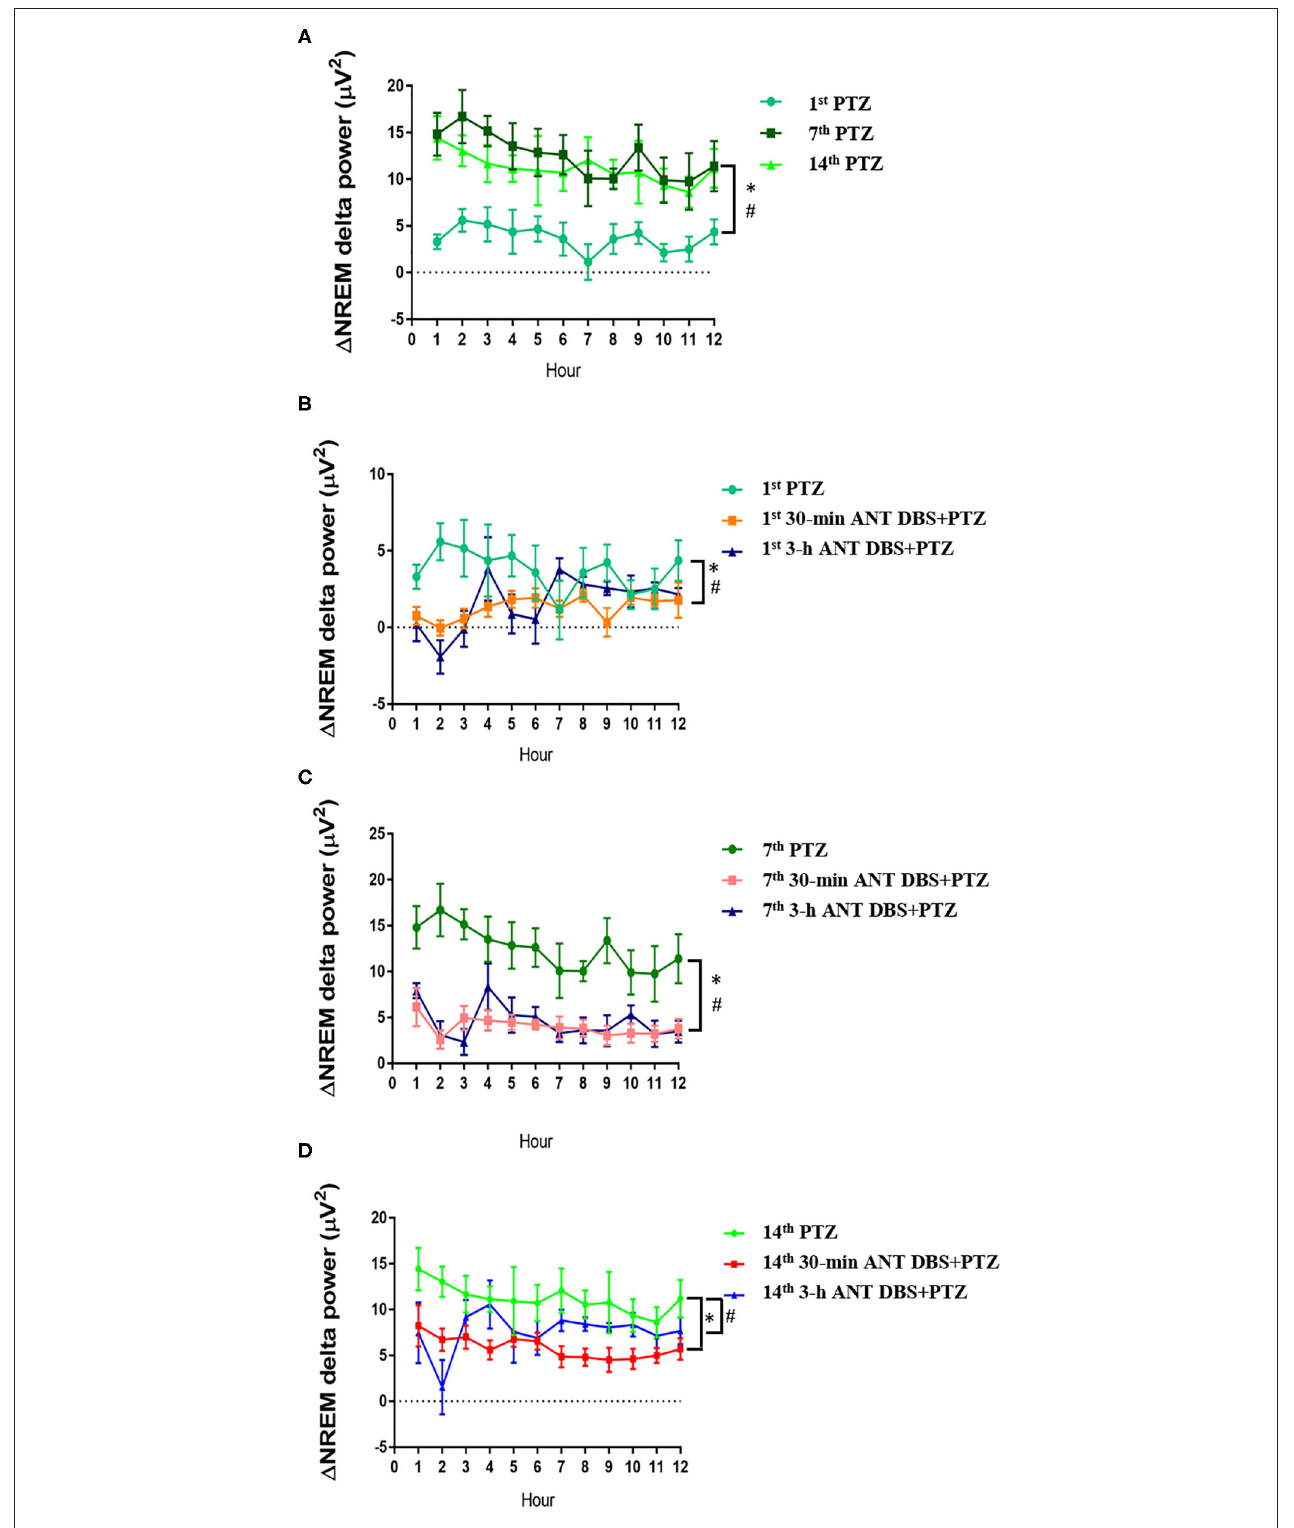
FIGURE 6 | The alteration of delta power during non-rapid eye movement (NREM) sleep ( 1 NREM delta power). (A) 1 NREM delta power obtained after the 1st, 7th, and 14th pentylenetetrazol (PTZ) injection comparing to that before the PTZ injection. * p < 0.05, 7th PTZ vs. 1st PTZ; # p < 0.05, 14th PTZ vs. 1st PTZ,